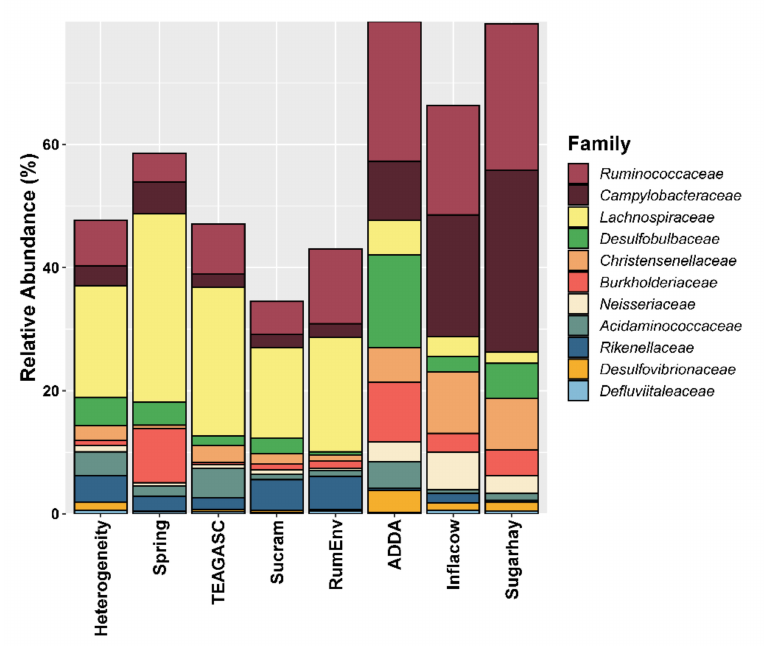
Figure 2. Relative abundance of core bacterial families found in > 90% of the samples per